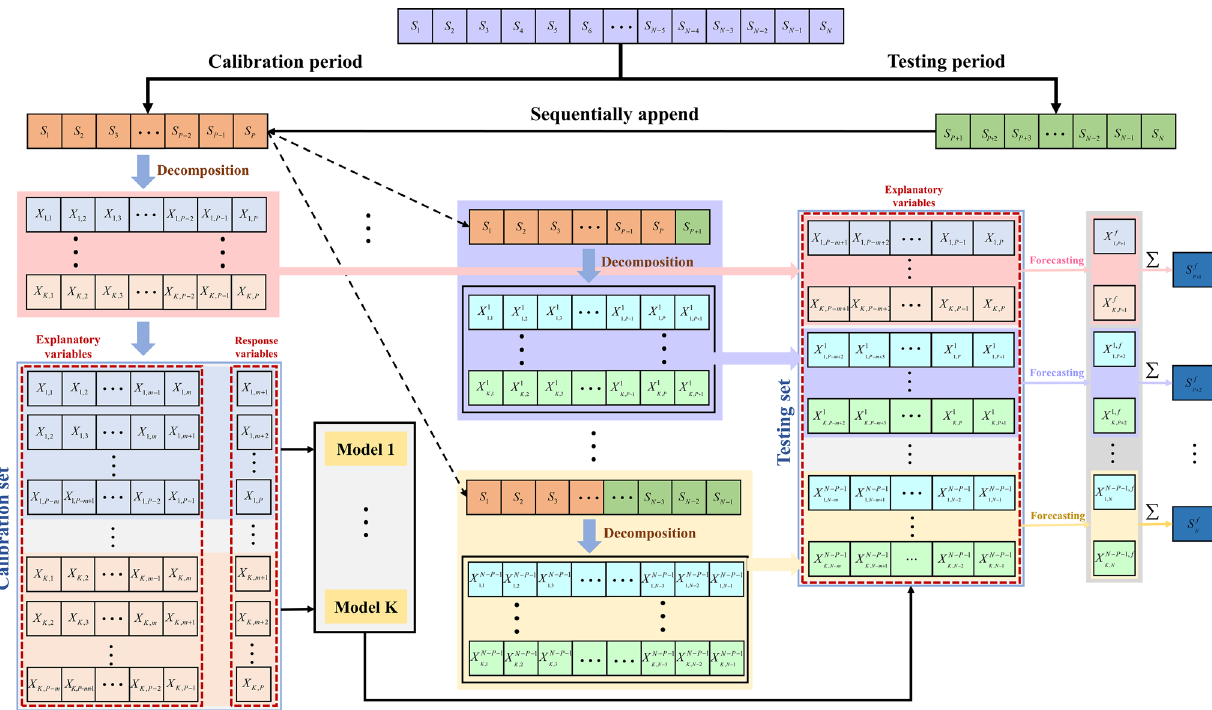
Fig. 2 The process of SSD sampling